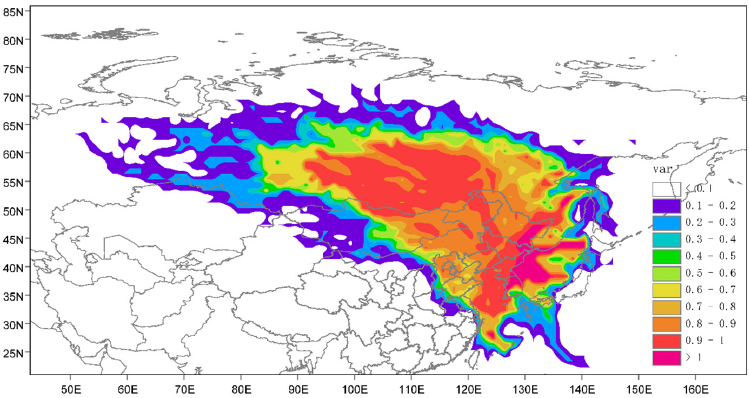
Figure 11. Weighted potential source contribution function (WPSCF) values for PM 2.5 .